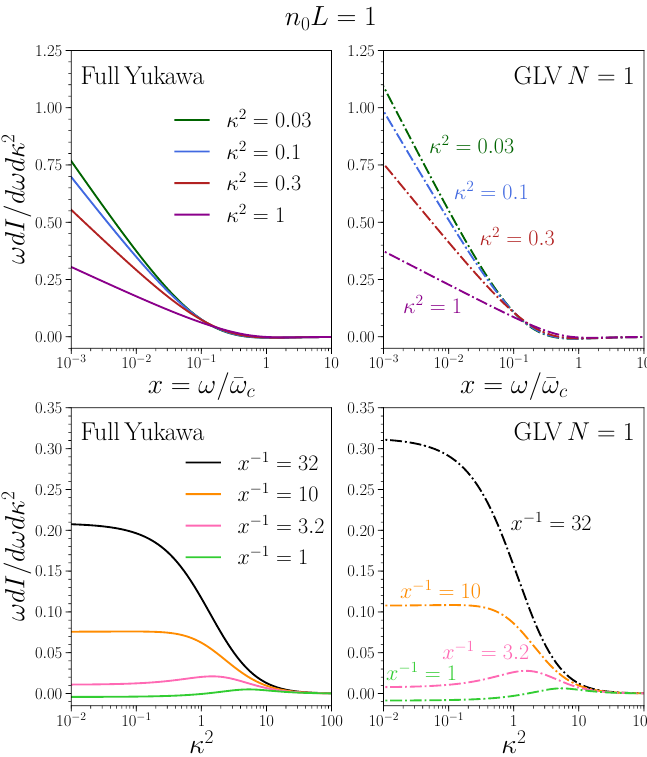
Figure 1 . Full medium-induced gluon radiation k ? -di(cid:11)erential spectrum for a medium with n 0 L = 1 for the Yukawa collision rate (left column) compared to the GLV (cid:12)rst opacity approximation (right column). The upper panels show these spectra as function of the rescaled gluon energy x = != (cid:22) ! c for (cid:12)xed values of the rescaled gluon transverse momentum (cid:20) = k=(cid:22) . The lower panels show these spectra versus (cid:20) 2 for (cid:12)xed values of x